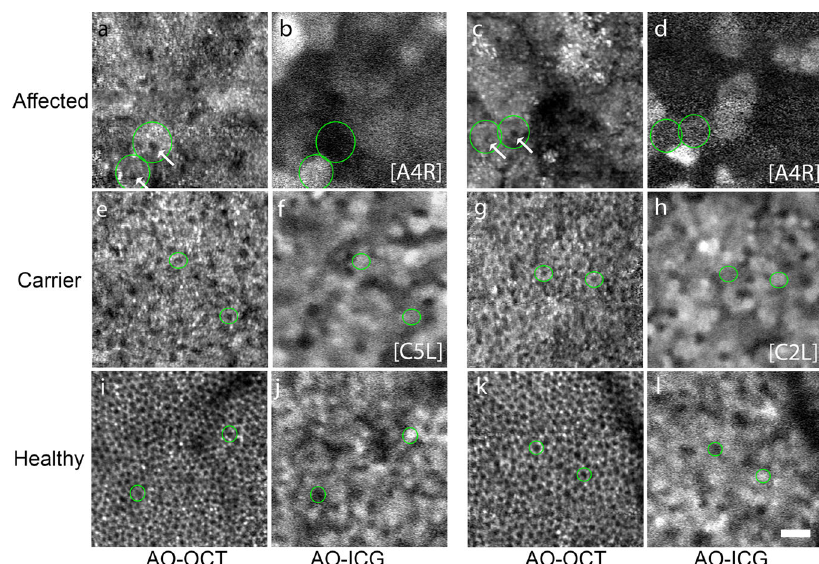
Fig. 2 Multimodal imaging corroborates the fi nding that the RPE cells are enlarged in choroideremia. Co-registered adaptive optics optical coherence tomography (AO-OCT) images and (AO-ICG) images from choroideremia are shown in comparison to healthy examples. a – h RPE cells from both affected males and female carriers are enlarged compared to ( i – l ) healthy RPE cells. Green circles are examples of individual RPE cells from each pair of images. RPE cell nuclei can be seen as the small dark spots in AO-OCT images (e.g., white arrows). The increased spacing between cell nuclei in choroideremia compared to healthy eyes can be seen in the AO-OCT images. The retinal locations (eccentricities) of the images are ( a , b ) 1.0 mm, ( c , d ) 1.5 mm, ( e – h ) 0.5 mm, ( i , j ) 0.5 mm, and ( k , l ) 1.5 mm. Scale bar, 50 µ